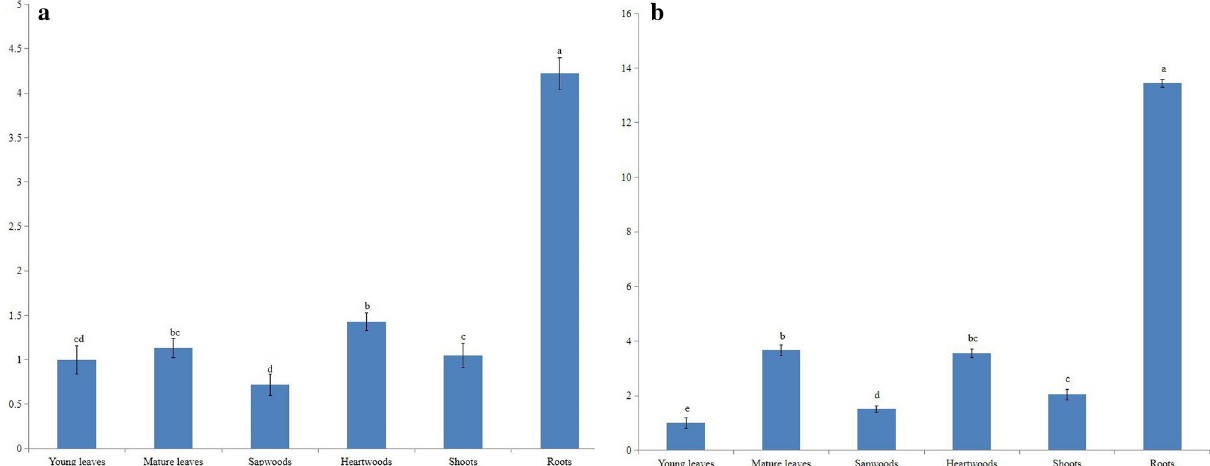
Figure 7. Gene expression levels of SaAACT ( a ) and SaHMGS ( b ) in different organs of Santalum album using qRT-PCR. The gene expression level of SaAACT and SaHMGS in the young leaves was set to 1. Data from qRT-PCR are means ± SD (standard deviation) from triplicate experiments (n = 3). Different letters indicate significant differences ( p < 0.05) following one-way ANOVA, using Duncan’s multiple range test.